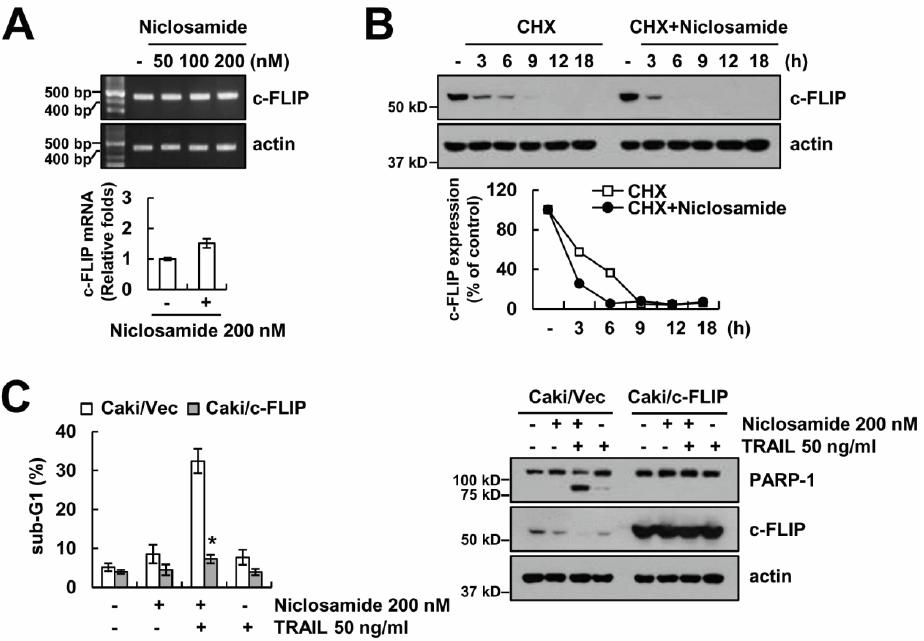
Figure 3. The down-regulation of c-FLIP is associated with the reduction of TRAIL resistance by niclosamide. ( A ) The messenger RNA (mRNA) expression was determined by reverse transcription polymerase chain reaction (RT-PCR) (upper panel) and quantitative polymerase chain reaction (qPCR) (lower panel) in Caki cells after treatment with niclosamide (50–200 nM) for 24 h. ( B ) The protein expression was determined by Western blotting in Caki cells after treatment with 200 nM niclosamide in the presence or absence of 20 μg/mL cycloheximide (CHX) for 3–18 h. The band intensity was measured using ImageJ. ( C ) Apoptosis levels and protein expression were determined by flow cytometry and Western blotting in Vector cells (Caki/Vec) and in c-FLIP-overexpressed cells (Caki/c-FLIP) after treatment with 200 nM niclosamide, and/or 50 ng/mL TRAIL for 24 h. The values in graph ( A , C ) represent the mean ± SEM of three independent samples. * p < 0.01 compared to niclosamide plus TRAIL-treated